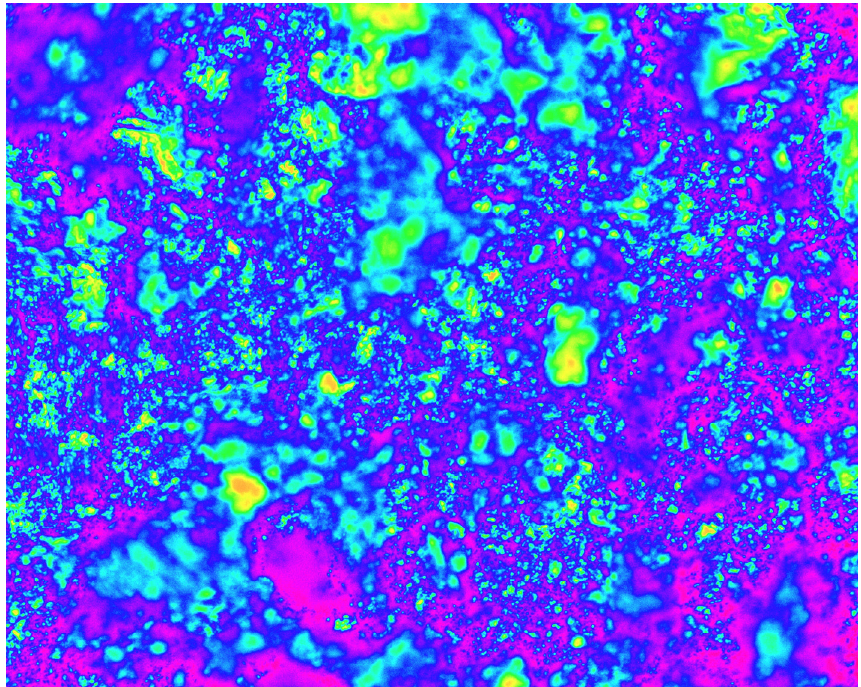
Figure A30. Photomicrograph of C 0 @n-Fe 0 . Reflected light, false color image. Purple = C 0 ; blue = porosity coated in n-Fe 0 ; yellow = adsorbed precipitated contaminant held within the porosity. Field of view = 0.1 mm.